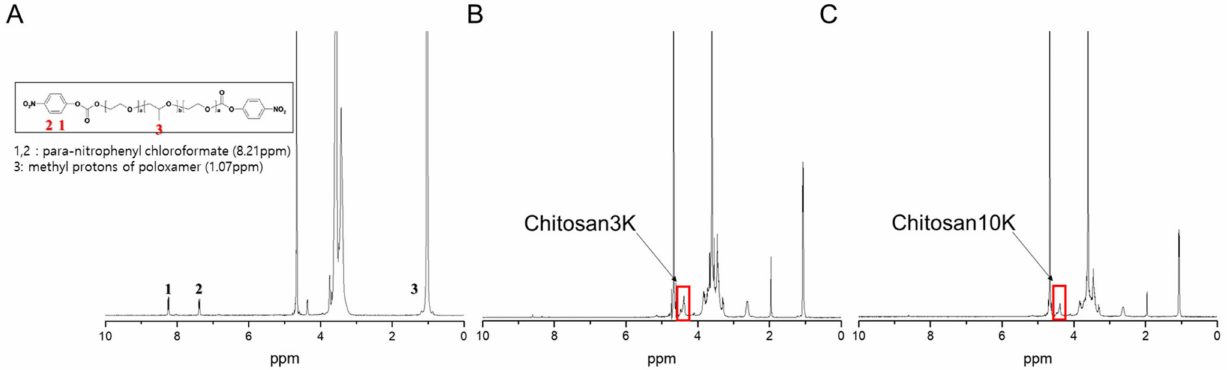
Figure 2. 1 H-NMR spectra of ( A ) p-NPC-poloxamer, ( B ) chitosan3K-poloxamer conjugate, and ( C ) chitosan10K-poloxamer conjugate in D 2 O.